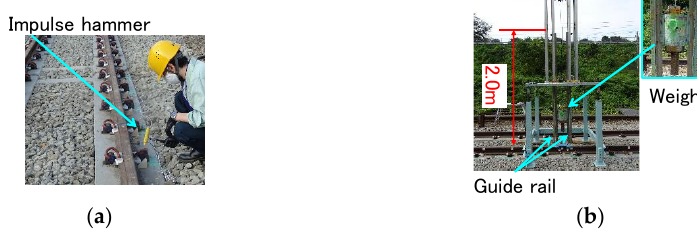
Figure 3. Situation of tests: ( a ) impulse hammer test; ( b ) weight-falling test.